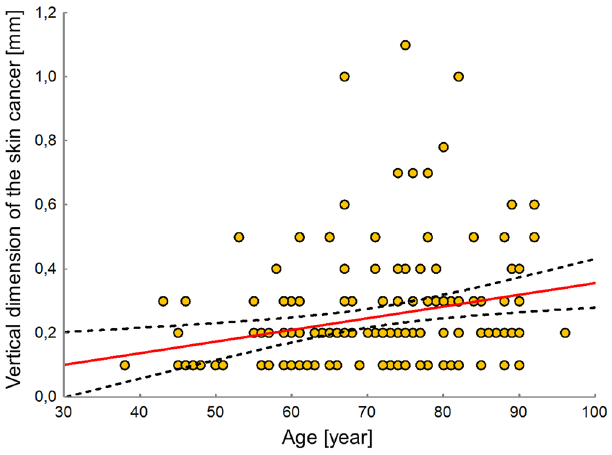
Figure 1. The association between age and skin cancer’s vertical dimension.